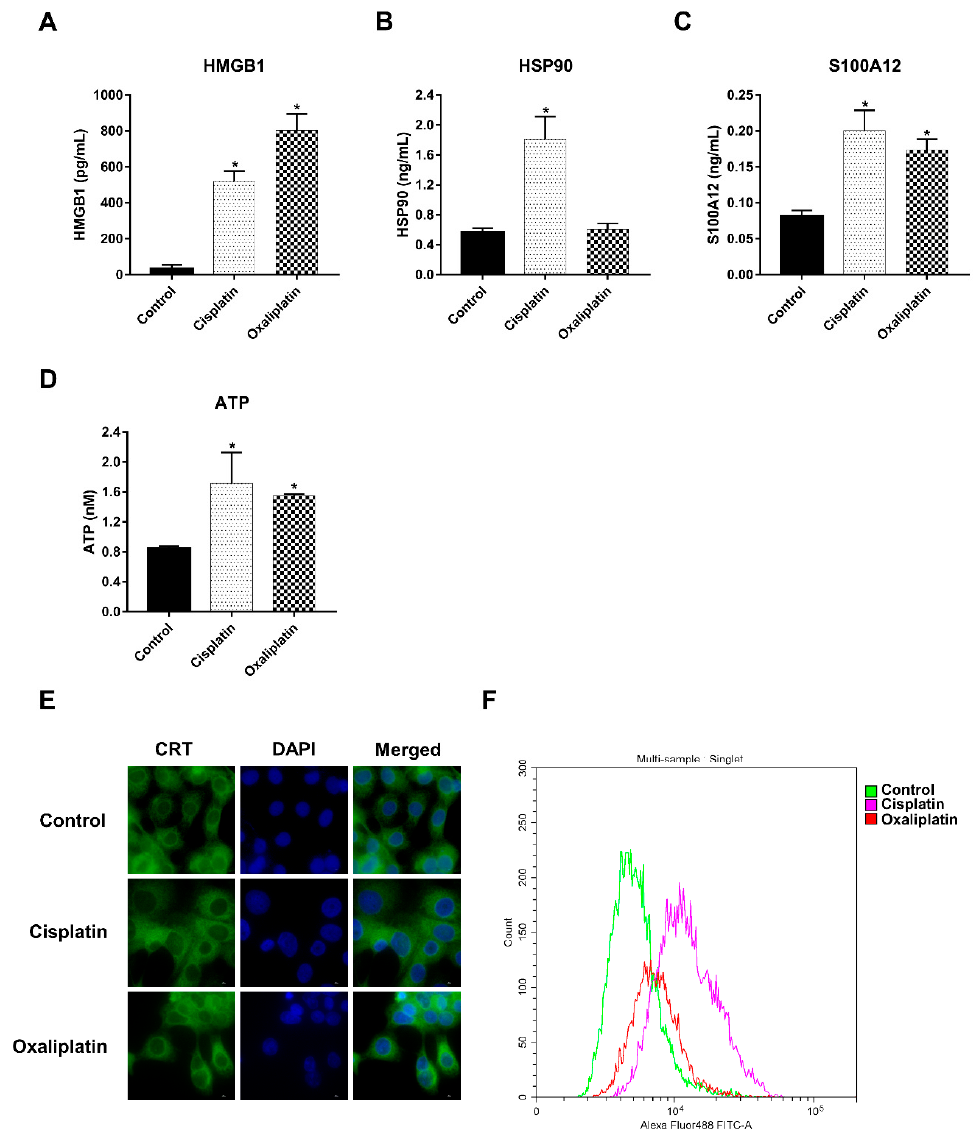
Figure 3. Cisplatin and oxaliplatin promoted DAMPs expression on CCA cell. The conditioned media of control or chemo drugs treatment were collected and measured the expression of ( A ) HMGB1, ( B ) HSP90 and ( C ) S100A12 by ELISA kit, and ( D ) ATP by fluorometric assay. Fluorescent staining ( E ) and flow cytometry cell surface expression ( F ) of CRT were investigated after treated with cisplatin and oxaliplatin. * p < 0.05.